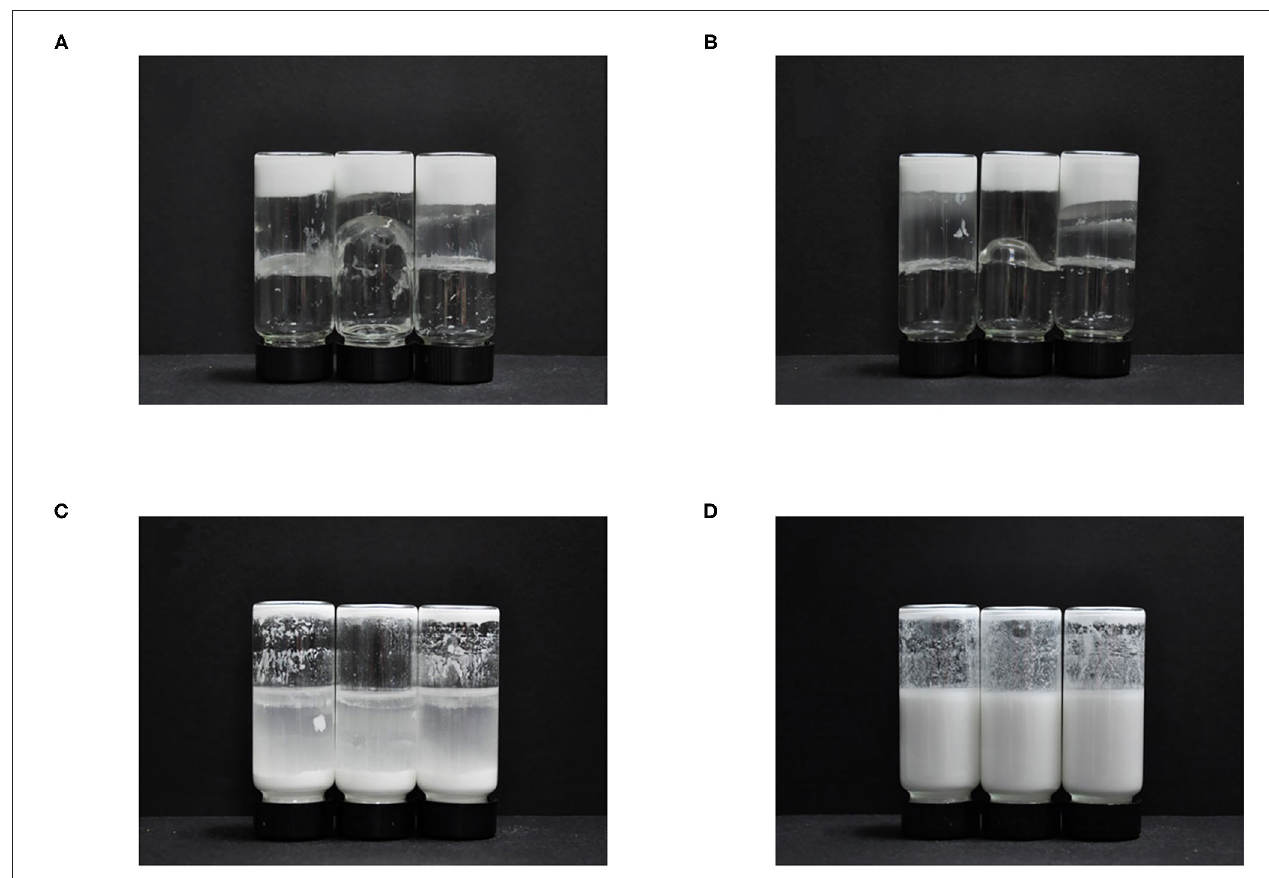
FIGURE 3 | Photos of CaCO 3 /SA emulsions after 6 months of storage: E1 (A) , E2 (B) , and E3 (C) emulsions stored at rest and E3 emulsion stored at rest for 20min after vigorous shaking (D)